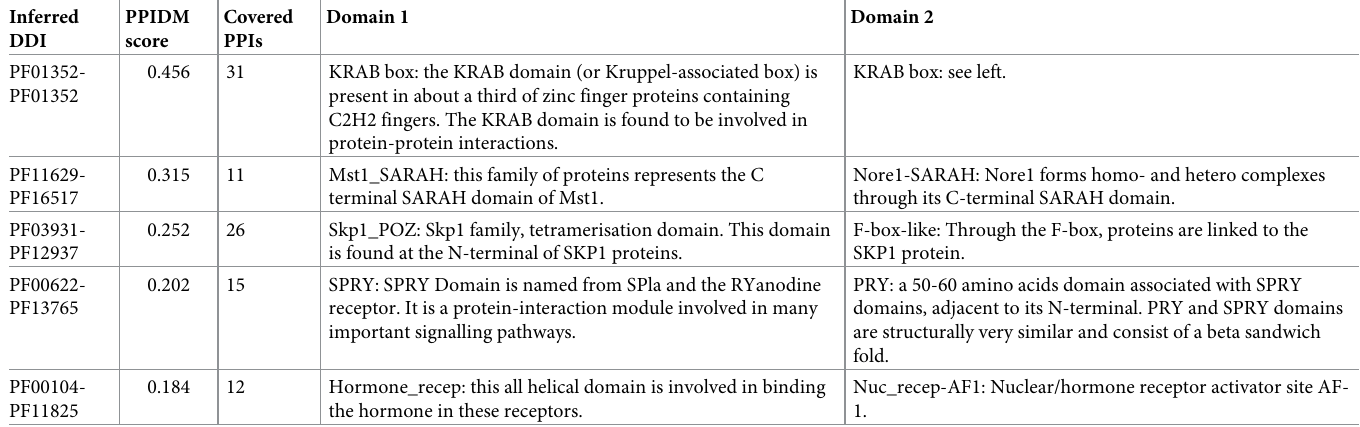
Table 4. Description of selected Gold DDIs newly inferred by PPIDM and absent from 3did2020 or DOMINE. The PPIDM consensus score and the number of covered PPIs in the IMEx database are indicated. The domain short name is taken from the corresponding Pfam entry and followed by a short description adapted from the corre- sponding Pfam